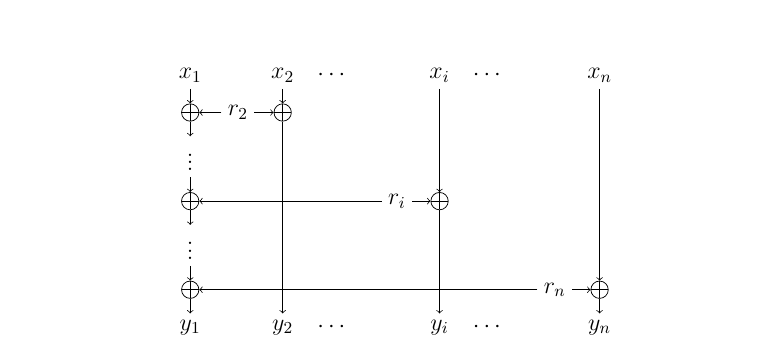
Figure 4: The RefreshMasks algorithm, with the randoms r i accumulated on the first